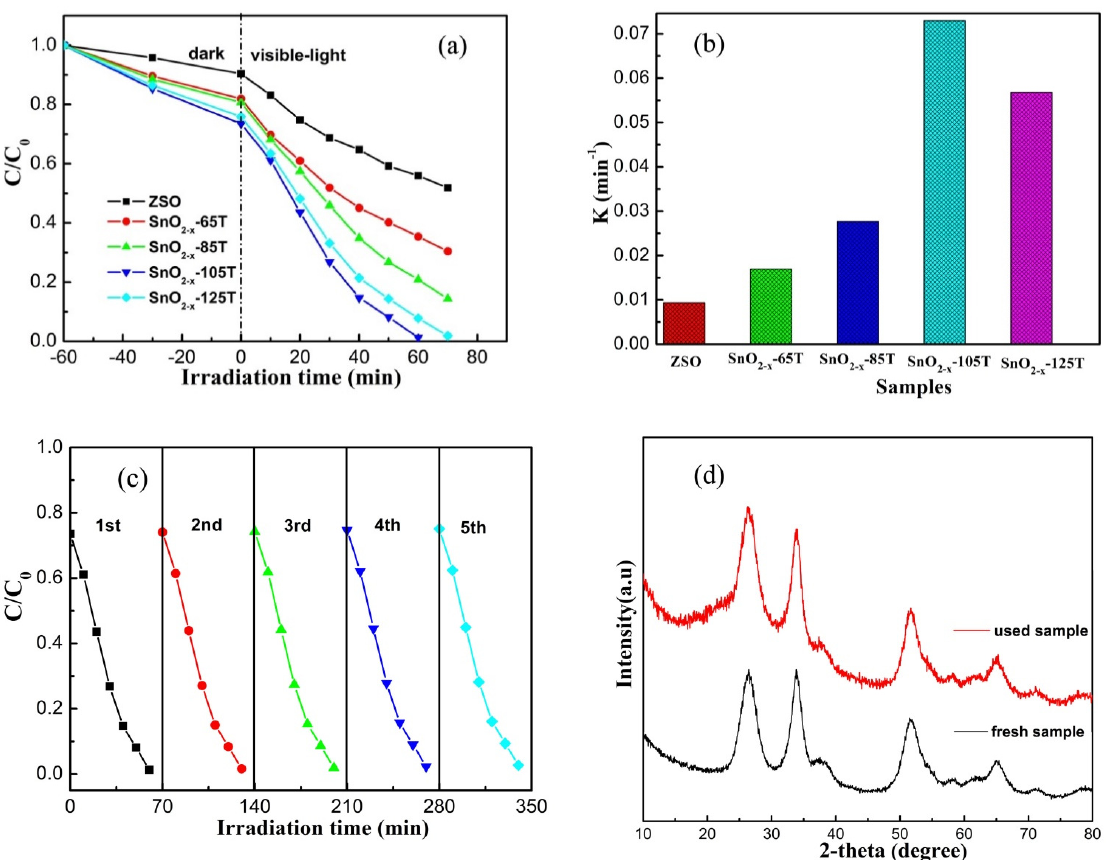
Figure 7. ( a ) The RhB photodegradation curves over different catalysts; ( b ) the corresponding ap- parent reaction rate constant; ( c ) cycling performance of the photodegradation of RhB solution over the SnO 2 − x -105T sample; ( d ) XRD pattern of SnO 2 − x -105T before and after use.